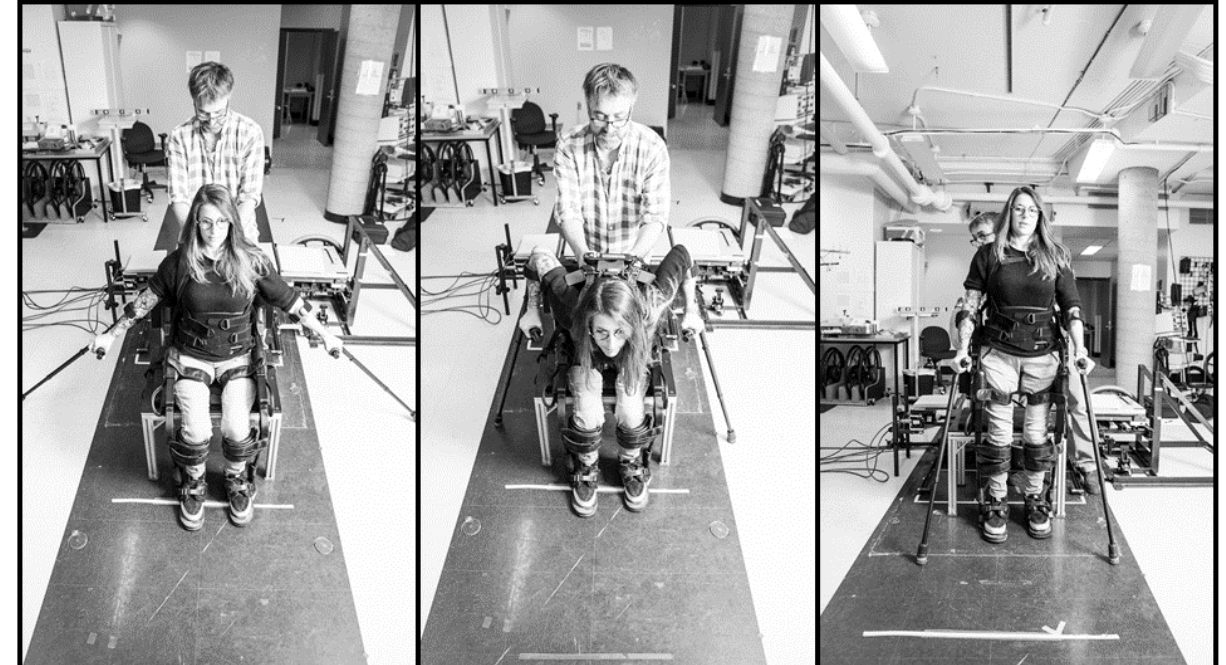
Figure 1. Wearable robotic exoskeleton for sit-stand transitions and overground walking manufactured by Ekso Bionics.